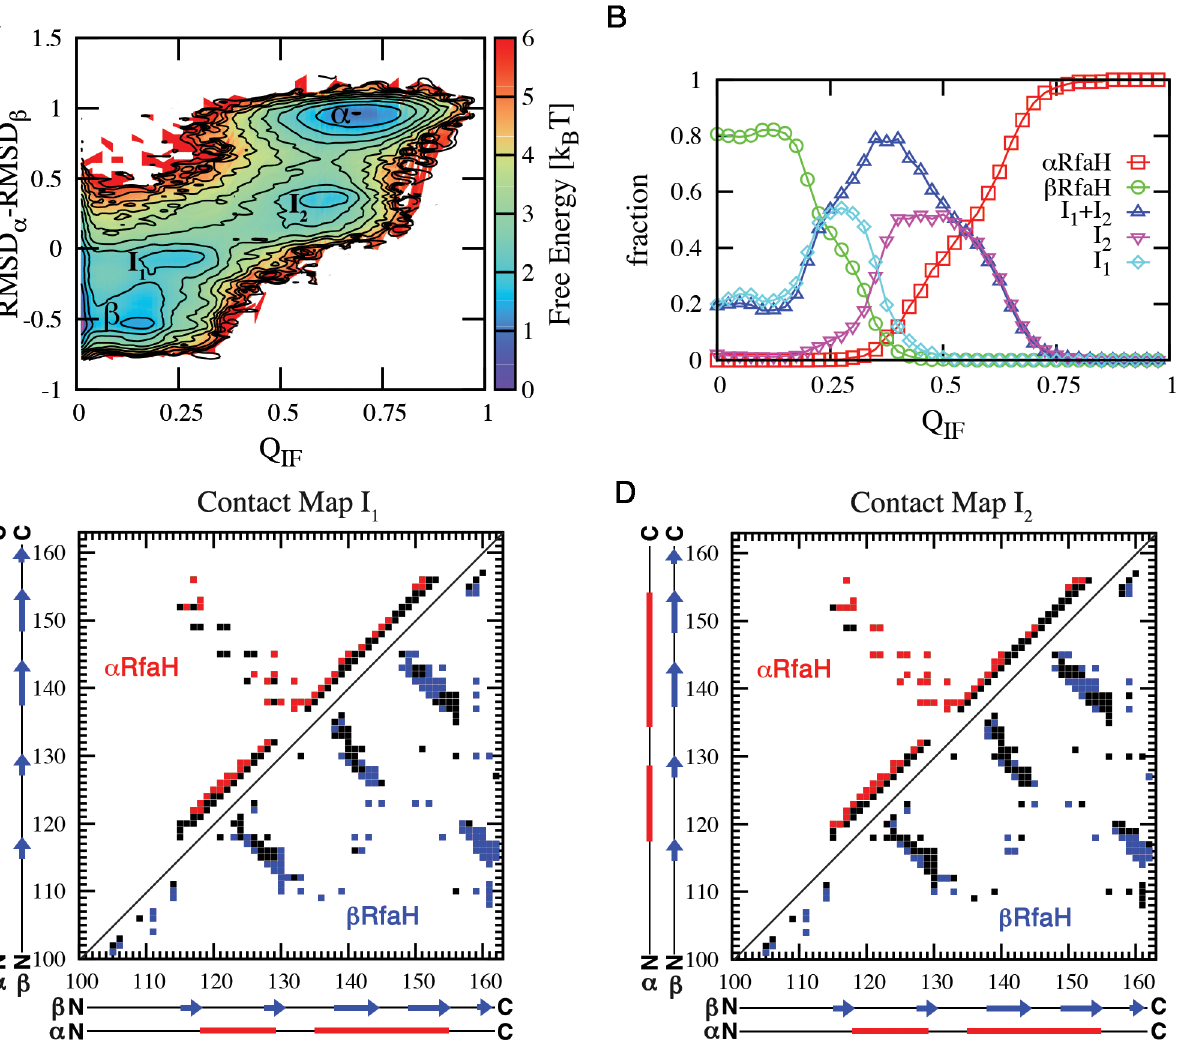
Fig 3. Interconversion between α and β involves folding intermediates that are interacting with the NTD. (A) Free energy landscape at ε IF C ¼ 0 : 51 ε , where the probability of α and β are equal, shows a three-state folding landscape: β /I 1 < - > I 2 < - > α . (B) Comparing ensembles as a function of Q IF , the fraction of interface contacts formed, shows that β and I 1 can form without interacting with the NTD, whereas I 2 and α are only found when interacting with NTD. The populations of β and I 1 near Q IF ~ 0.2 indicates that these con fi gurations present a small amount of surface residues that make contacts with the NTD in the α structure. States were de fi ned as RMSD β – RMSD α ranges: [-0.80, -0.30] as the β state, [0.80, 1.20] as the α state, and [-0.25, 0.00] and [0.15, 0.60] as the I 1 and I 2 ensembles. Contact maps of intermediate states I 1 (C) and I 2 (D) were constructed by isolating these ensembles from simulations at T = 0.92 T F β and then determining the native contacts from α CTD (red) and β CTD (blue) that have a contact probability >